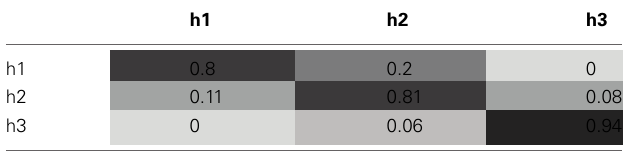
on the left, after application of our algorithmic simulation of motor (cid:20) (cid:21) (cid:6) H = 1 deterioration middle : medium impairment, (cid:20) (cid:21)(cid:7) impairment, H = 3 .